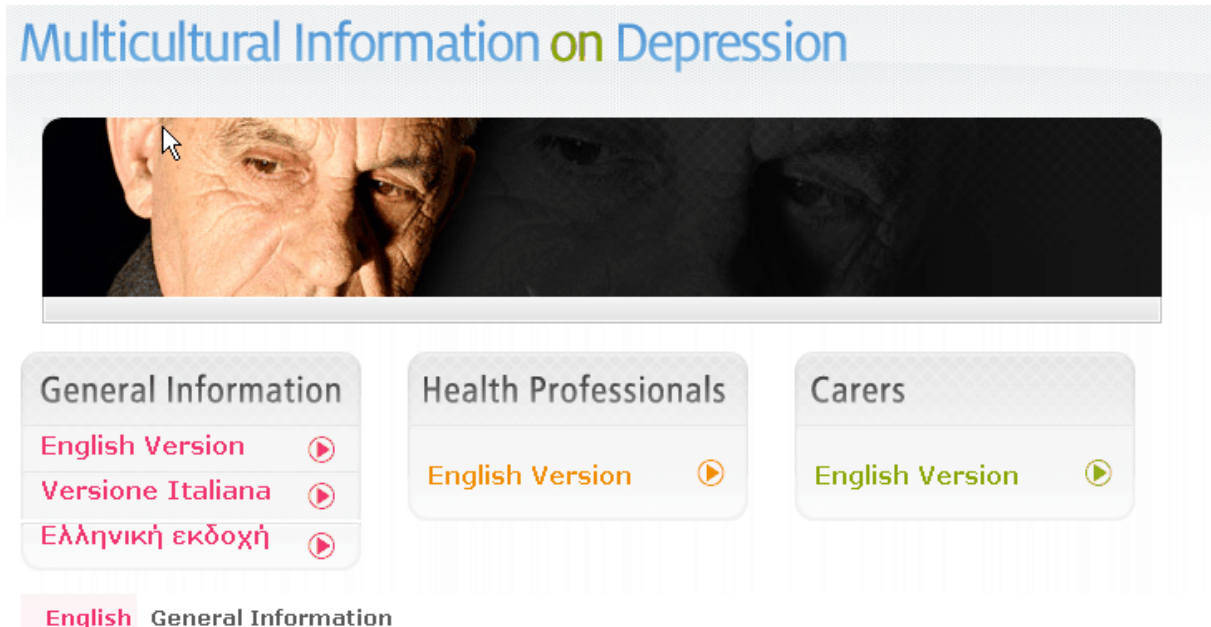
Figure 1. Screenshot of the MIDonline website intervention in